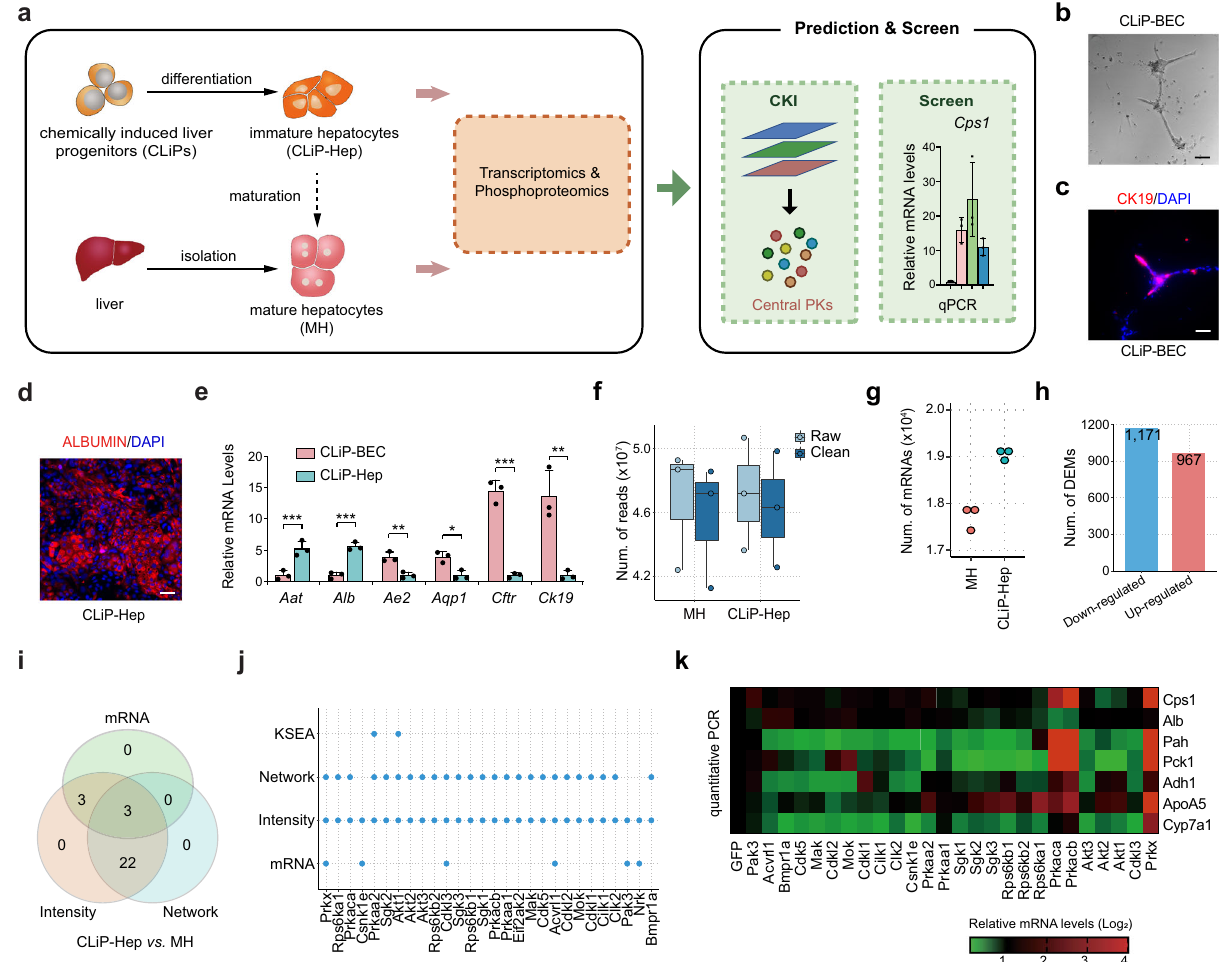
Fig. 2 | CKI-based analysis of mouse hepatocyte maturation. a Experimental design of the trans-omics-based analysis of immature hepatocytes generated from liverprogenitorcells(CLiP-Hep)andmaturehepatocytes(MH)isolatedfrommouse liver.Representativeimageofbileductstructure( b )andCK19immuno fl uorescence staining ( c ) of biliary epithelial cells induced from liver progenitor cells (CLiP-BEC). Scale bars=100 μ m. n =4 biological replicates. d Immuno fl uorescence staining of ALBUMIN in hepatocytes generated from CLiPs (CLiP-Hep). Scale bars=100 μ m. n =3 biological replicates. e Gene expression analysis by RT-qPCR demonstrated signi fi cant differences of hepatic and biliary marker genes between CLiP-BEC and CLiP-Hep cells for Aat ( p = 0.0067), Alb ( p = 0.0007), Ae2 ( p = 0.0065), Aqp1 ( p =0.0109), Cftr ( p =0.0002), Ck19 ( p =0.0065), n = 3biologicalsamples.Dataare